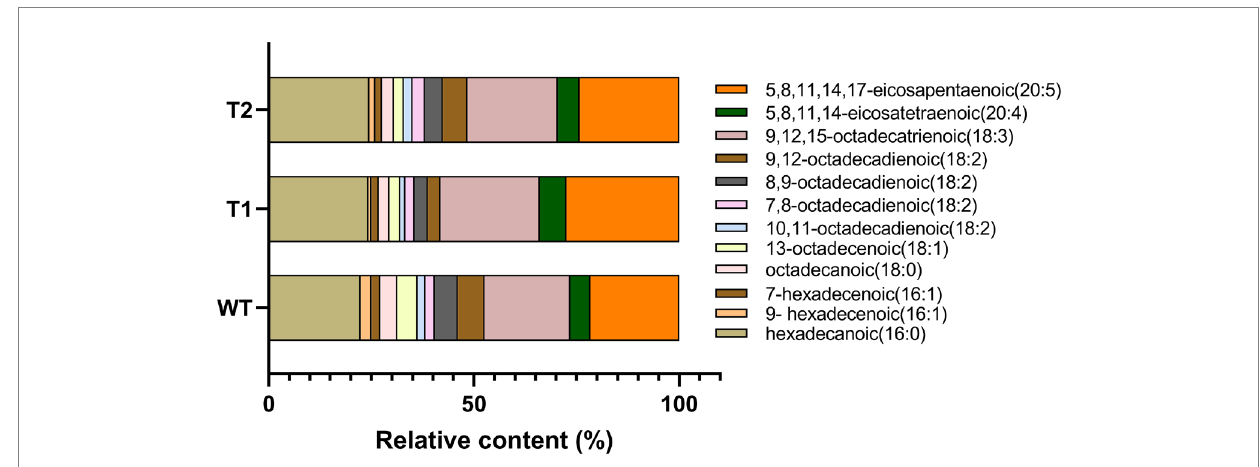
FIGURE 6 Statistical chart of relative content of various fatty acids based on GC–MS results. The original chromatogram can be found in Supplementary Material Figure